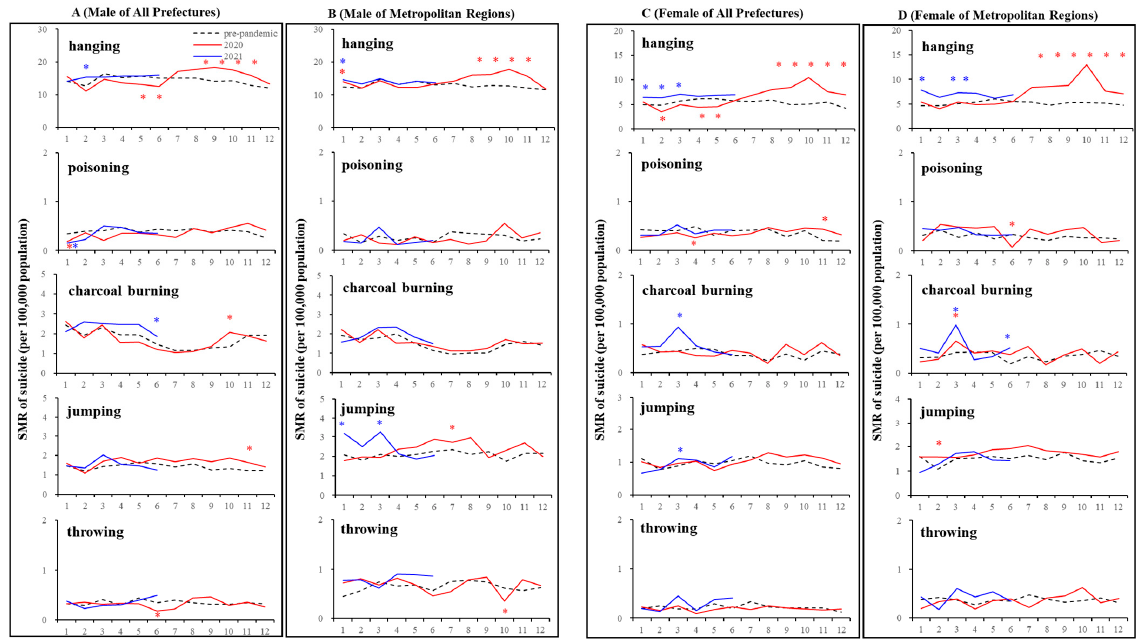
Figure 8. Temporal fluctuations in monthly SMR-S disaggregated by gender, suicidal means, and regional factors during COVID-19 pandemic period (2020–2021) compared to the average of SMR-S in the same month during the pre-pandemic period (2017–2019). Dotted black, red, and blue lines indicate the average of SMR-S for ( A ) males from all 47 prefectures, ( B ) males from metropolitan regions, ( C ) females from all 47 prefectures, and ( D ) females from metropolitan regions. Ordinates indicate the SMR-S (per 100,000 people), and abscissas indicate the month. * p < 0.05, significant change using a linear mixed-effects model with Tukey’s multiple comparison. Red and blue asterisks indicate significant changes in SMR-S in 2020 and 2021, respectively, compared to the average SMR-S of the same month during the pre-pandemic period.